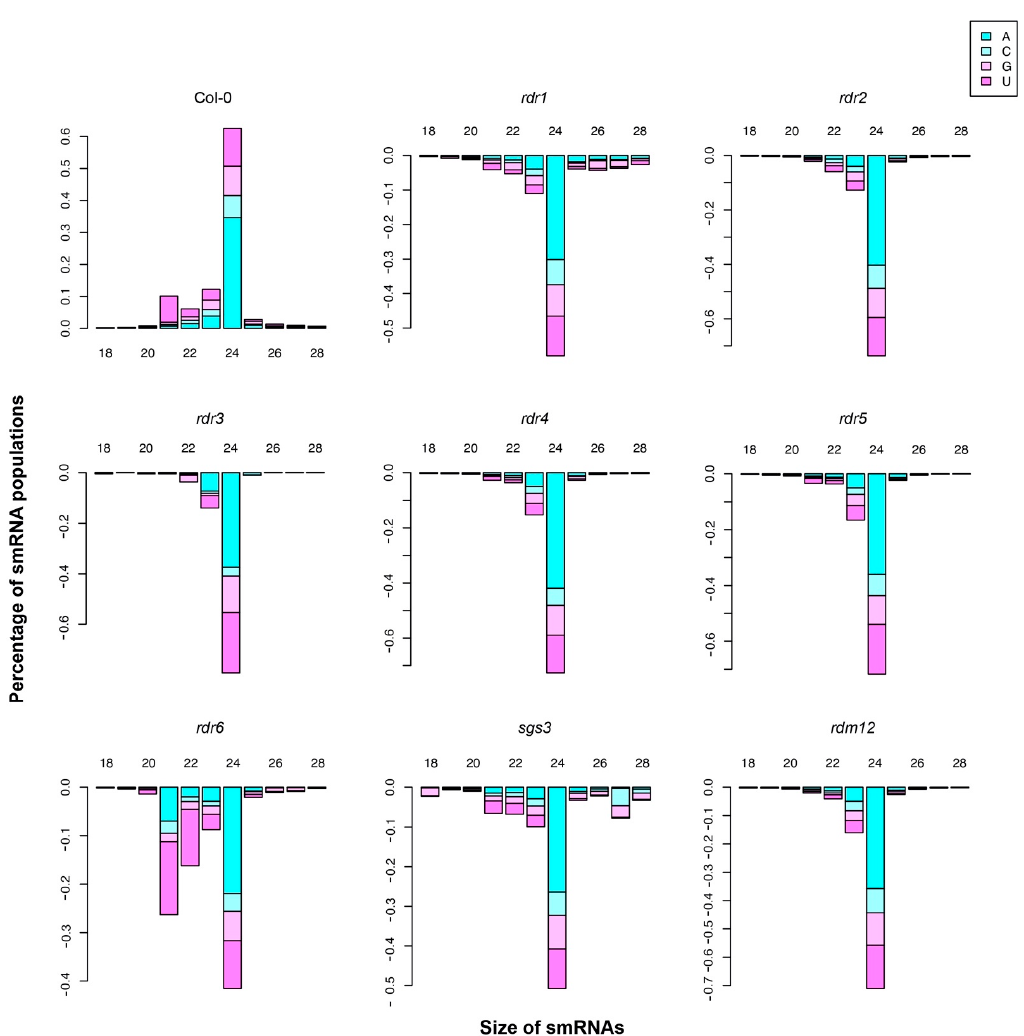
Figure 1. Small RNA population breakdowns for the six Arabidopsis RDR proteins and two of their cofactors (SGS3 and RDM12). The smRNAs were mapped to unbiased 500 nt genomic bins; the smRNA populations identified in Col-0 and smRNAs lost in rdr1–6 , rdm12 , and sgs3 mutant plants (as specified) were plotted based on smRNA length and 5 ′ terminal nucleotide.